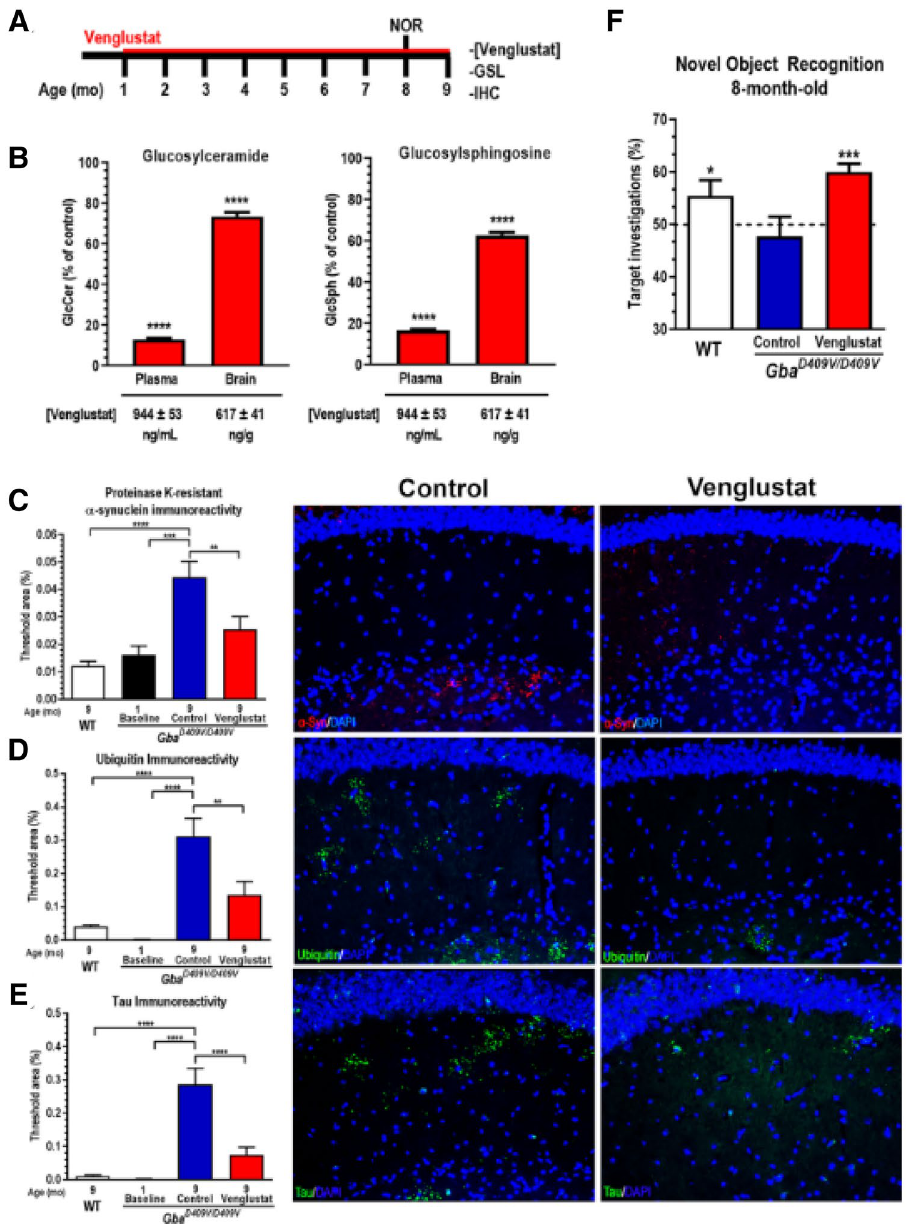
Figure 3. GCS inhibition by venglustat reduced glycosphingolipids and brain protein aggregate accumulations and improves the hippocampal-related memory deficit in a Gaucher-related synucleinopathy mouse model. ( A ) Timeline of sustained venglustat administration in Gaucher-related synucleinopathy mice ( Gba D409V/D409V ) and endpoints. Four-week-old animals were fed venglustat in pelleted diet (0.03% wt/wt) and control Gba D409V/D409V mice were fed the same diet minus the drug as described in the Methods. Animals were euthanized after 8 months of treatment. NOR: novel object recognition behavioral assay; GSL: glycosphingolipid measurements; IHC: immunohistochemical analysis and quantification. ( B ) Venglustat significantly lowered GlcCer ( left ) and reduced GlcSph ( right ) accumulation in plasma and brain of treated Gba D409V/D409V mice. Results are represented as the mean ± SEM, N ≥ 17 per group. Unpaired t -test; **** p < 0.0001. ( C – E ) Brain sections from WT and Gba D409V/D409V mice were immunostained for proteinase K-resistant α-synuclein ( C ), ubiquitin ( D ), and tau ( E ) aggregates. Venglustat treatment significantly reduces the accumulation of aggregated proteins in the hippocampi of Gba D409V/D409V mice. The representative images ( right ) demonstrate proteinase K-resistant α-synuclein immunoreactivity ( C ; red), ubiquitin immunoreactivity ( D ; green), and tau ( E ; green) of control and venglustat-treated Gba D409V/D409V mice at 9 months of age. DAPI-stained cell nuclei are shown in blue. One-way ANOVA followed by Tukey’s post-hoc analysis. All data represent the mean ± SEM, with N = 9–20 per group; ** p < 0.01; *** p < 0.001; **** p < 0.0001. ( F ) Gba D409V/D409V mice were subjected to the novel object recognition test 7 months after treatment initiation. No groups exhibited preference during training when presented with two objects (data not shown). After 24 h, mice were presented with a novel object during the testing. WT mice showed significant preference for the novel object as indicated by an increase in the number of investigations of the novel object ( white bar ). Gba D409V/D409V control mice ( blue bar ) showed no preference for the novel object, indicating cognitive impairment while venglustat treated Gba D409V/D409V mice ( red bar ) demonstrated preference for the novel object as indicated by a significant increase in investigations of the novel target. Results demonstrate that venglustat treatment corrects the memory impairment in Gba D409V/D409V mice. Column statistics with one-sample t -test. * p < 0.05 and *** p < 0.0001 signify means are significantly different than theoretical mean of 50%. N ≥ 17 per